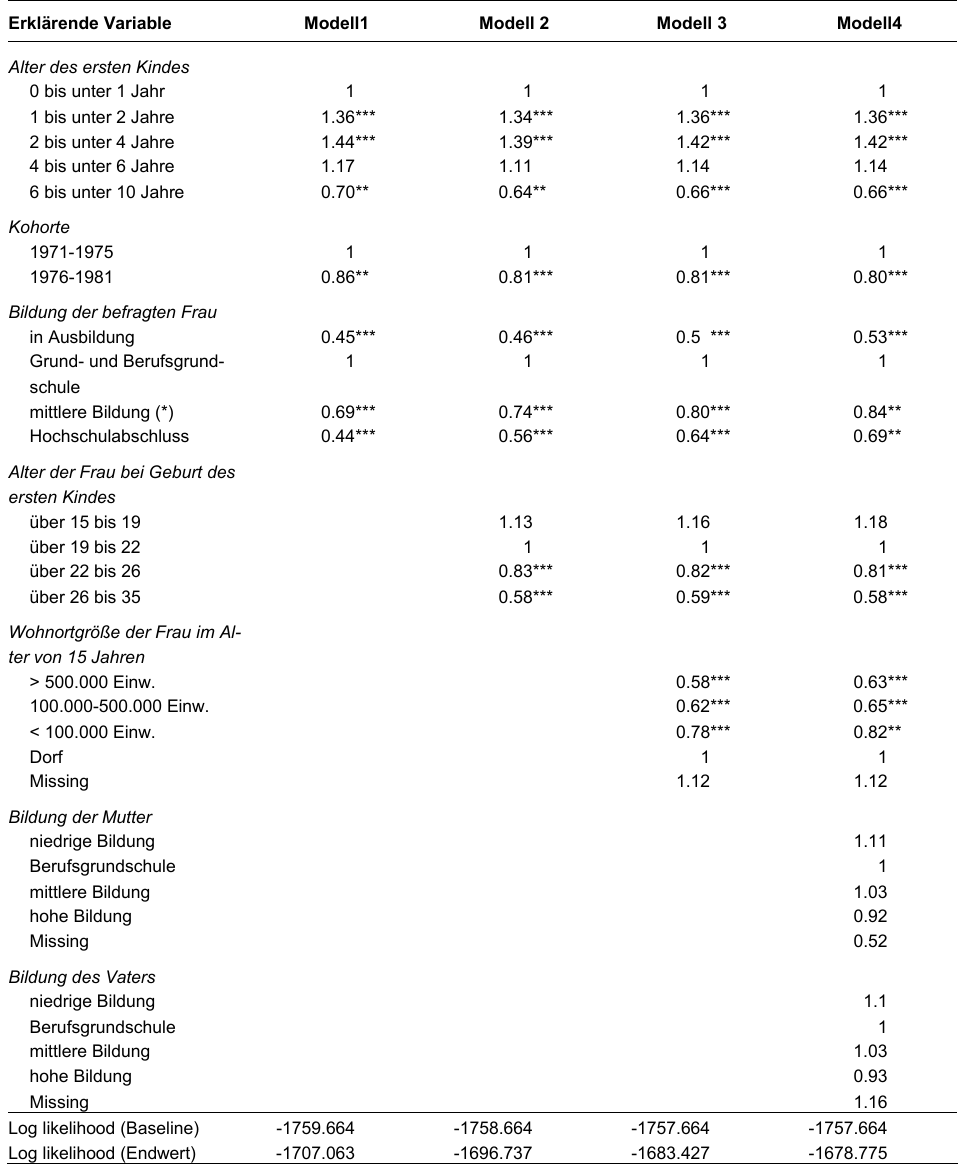
Tabelle 2: Relative Risiken des Übergangs zum zweiten Kind in Polen. Ergebnisse